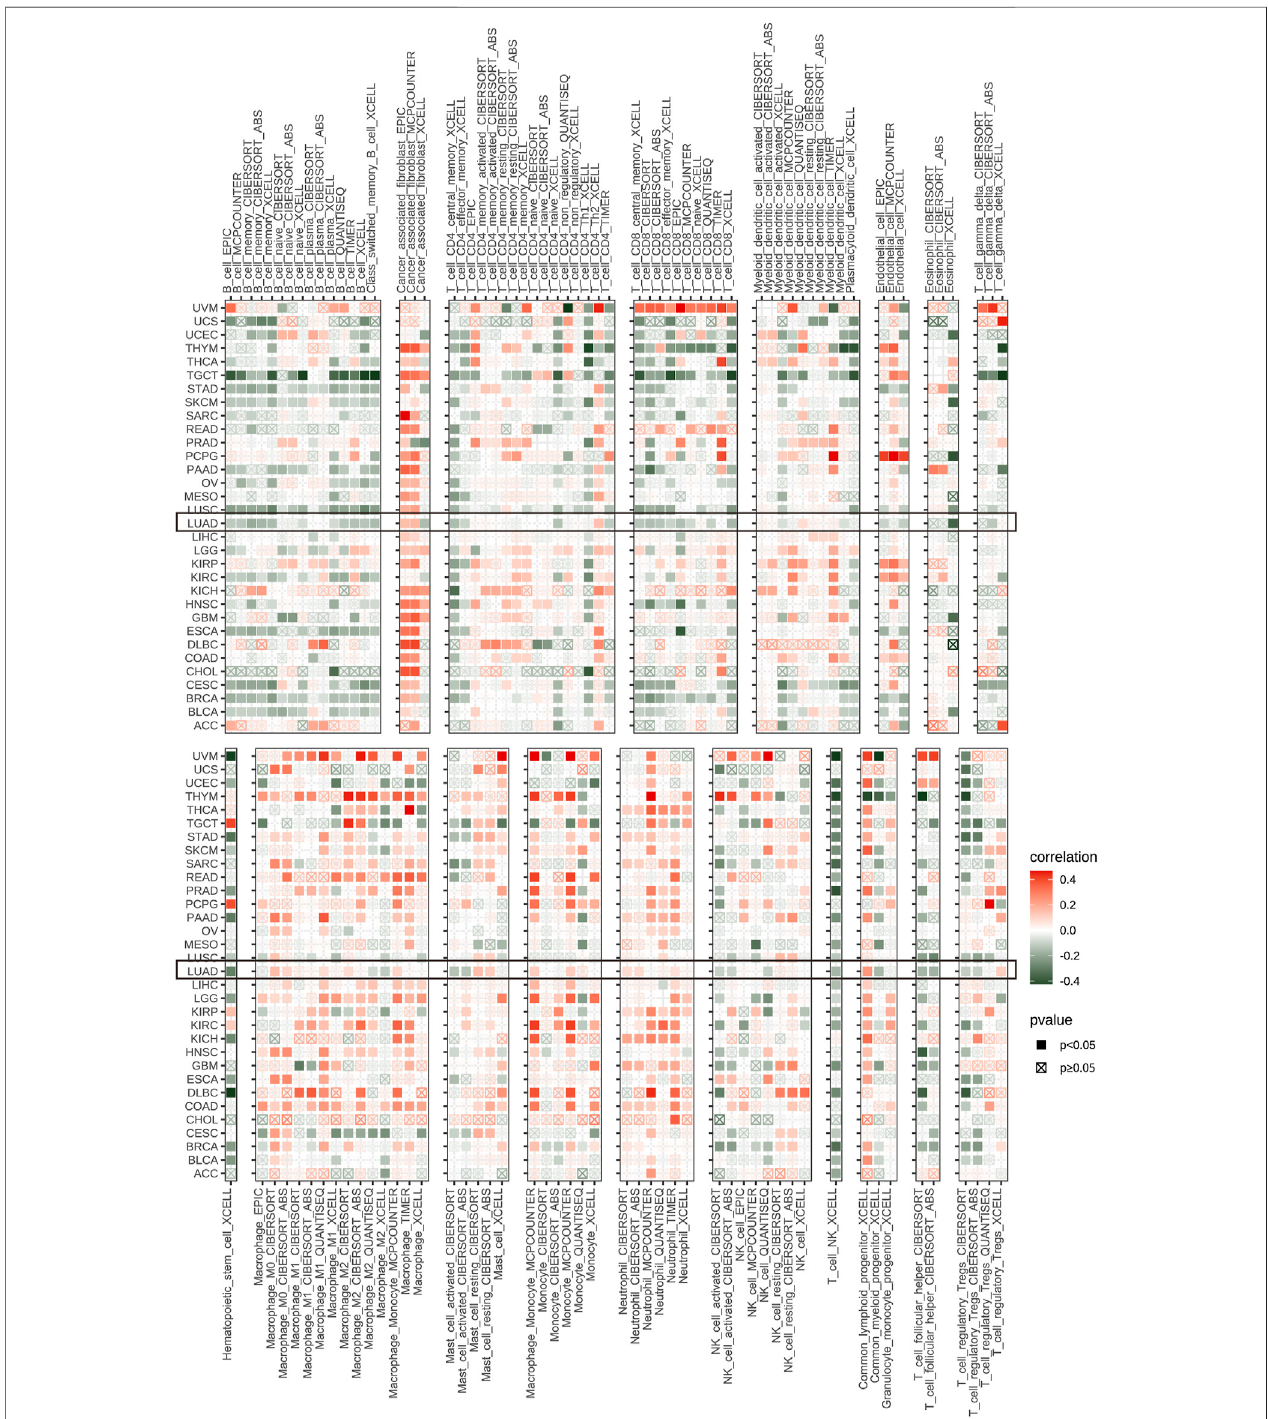
FIGURE10 | Immune in fi ltration analysisbased ondata from TIMER2 database. The relationship betweenP4HA1 expression and in fi ltration levels ofimmune cells in pan-cancer. Red represents positive correlation, green represents negative correlation, and the darker the color, the stronger the correlation. * p < 0.05, ** p < 0.01, *** p < 0.001, **** p < 0.0001.